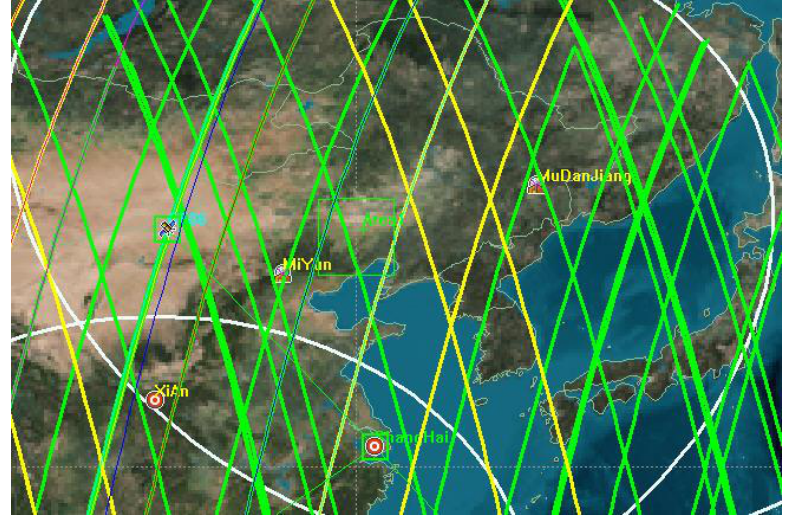
Figure 3. Schematic diagram of resource satellite’s access to regional targets.